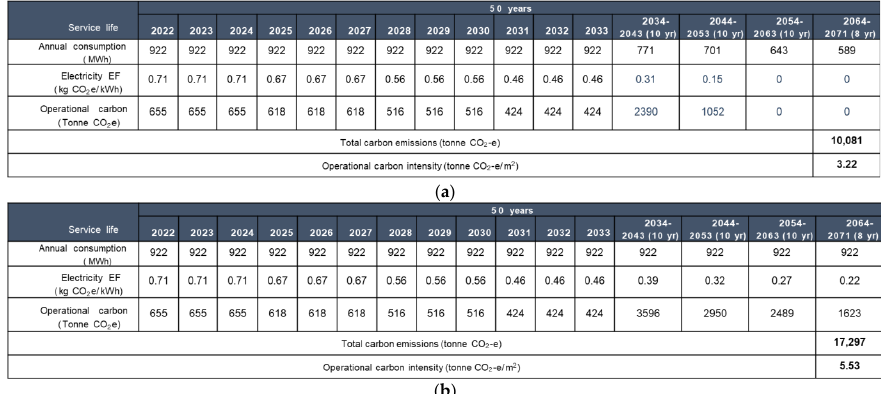
Figure 8. Operational carbon prediction over the 50-year building lifecycle. ( a ) Operational carbon for 1.5 °C Net-Zero World Scenario (for Model 1). ( b ) Operational carbon for 3 °C Hot House World Scenario (for Model 1).